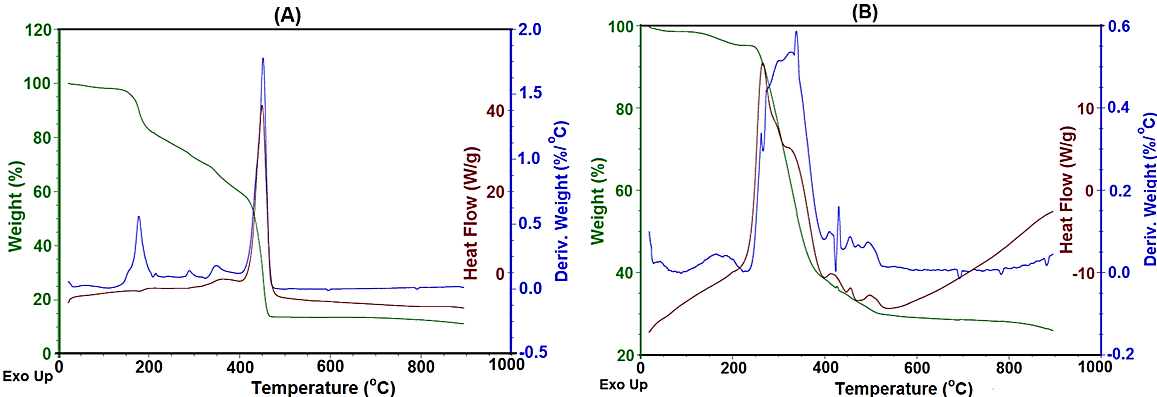
Figure 7. Thermograms of representative terpolyamide F3 ( A ) and block copolymer PF3 ( B ). TGA green lines, DTG (blue lines), and DSC (red lines). Table 2. Thermal properties of the ferrocene-based terpolyamides, block copolymers, and their cor- responding organic analogs.